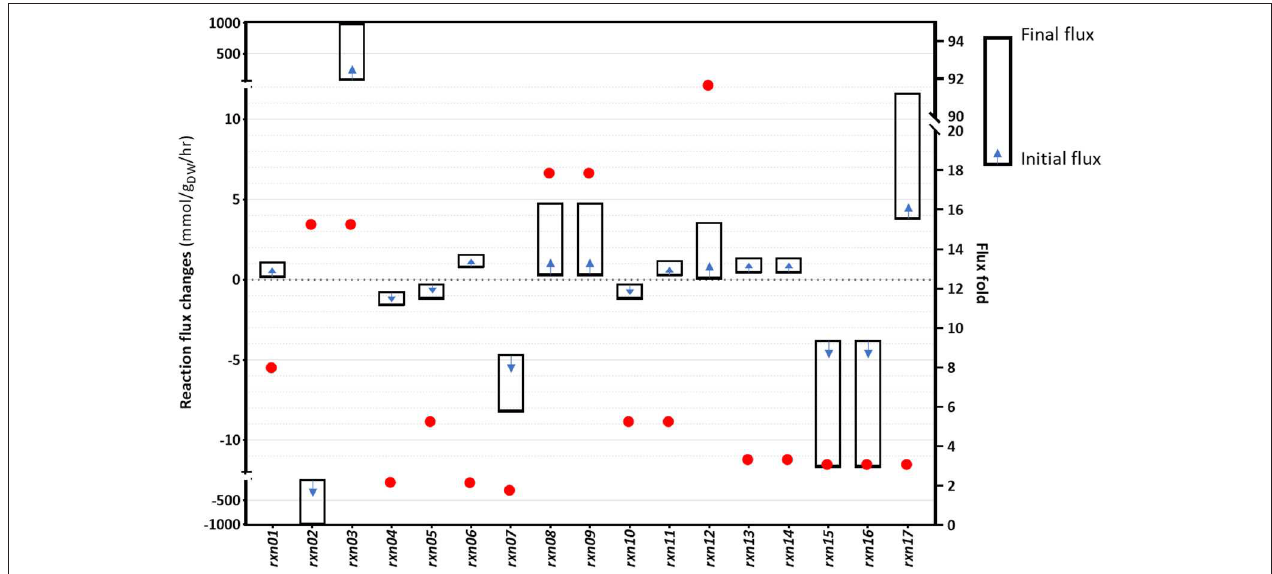
FIGURE 6 | The results of the FSEOF simulation: The identified reactions and their flux changes during simulations.